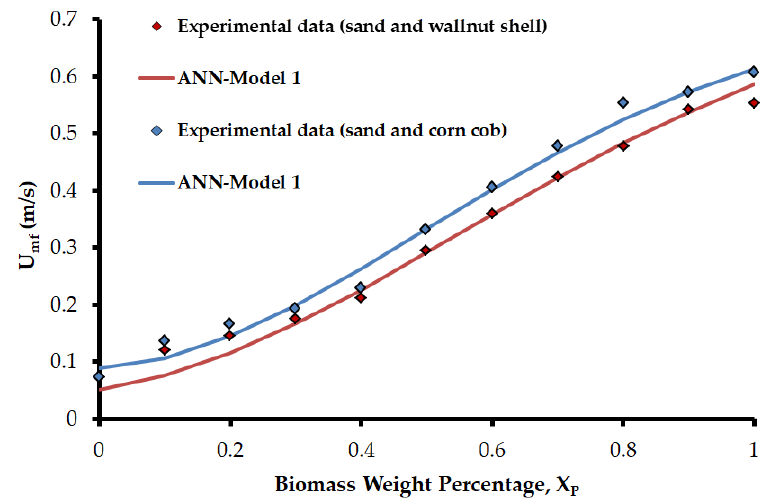
Figure 5. Simulations using ANN-Model 1 for the experimental data of case [31]. Match between experimental data and model’s predictions. ρ F = 2630 kg/m 3 , d F = 240 µm (sand), ρ P =1200 kg/m 3 , d P = 856 µm (walnut shell), ρ P =1080 kg/m 3 , d P = 1040 µm (corn cob).